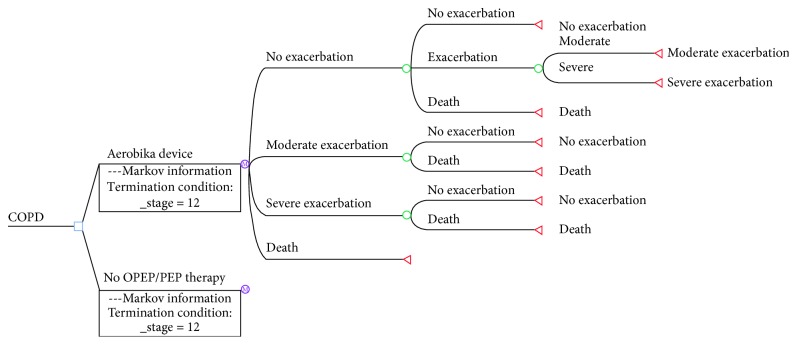
Model structure.